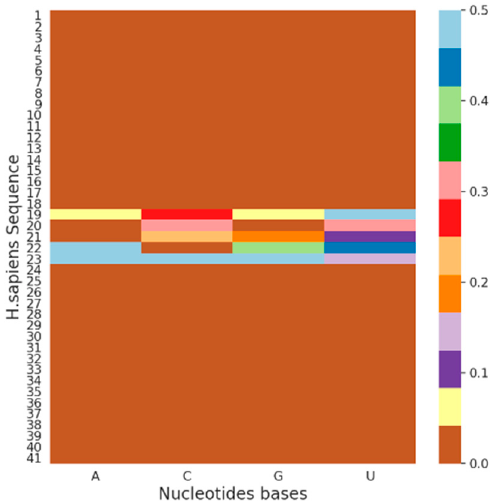
Figure 4. Visualization of mutation effect using in silico mutagenesis approach for H. sapiens species. This shows the difference between the mutated sequence and reference. Nucleotide base A in the sequence was not affected significantly compared with other nucleotides bases of H. sapiens species shown in the figure.